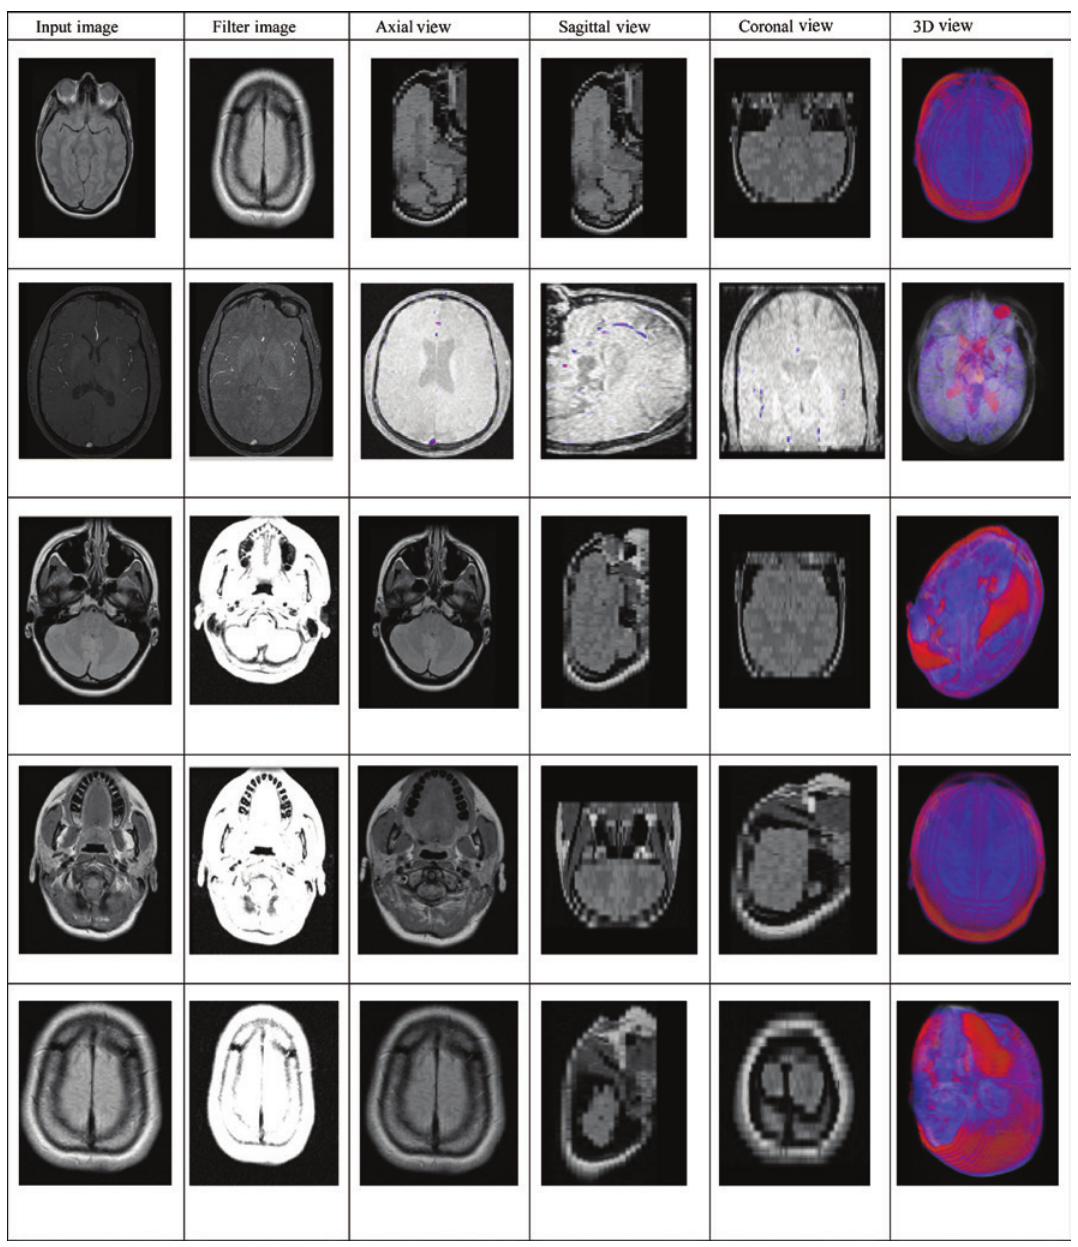
Table 1: Experimental Results Obtained by Various Medical Image Data